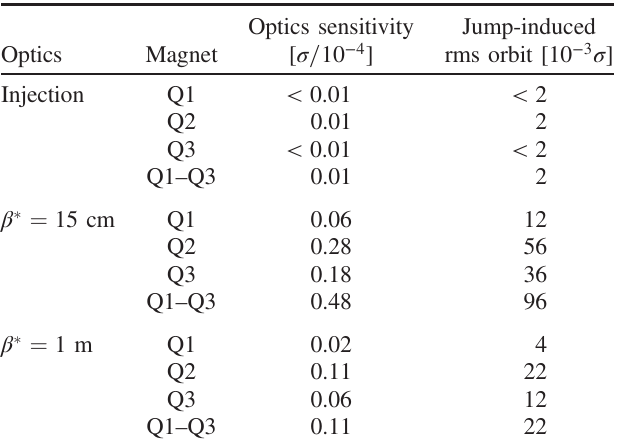
TABLE III. R.m.s. closed orbit variation at HL – LHC TCPs under the effect of the expected flux jumps for each half quadrupole composing the triplet (Q1; Q2; Q3) and for a whole triplet (Q1 – Q3) computed in units of beam sigma. The optics sensitivity in units of beam sigma per unit of magnetic field change is also reported.